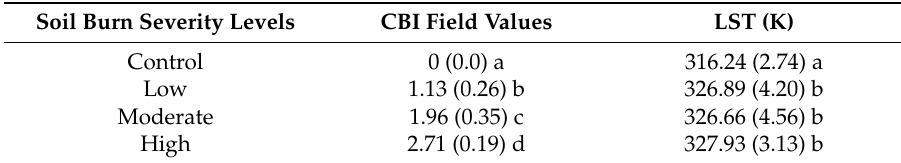
Table 5. Mean values and ( ± standard deviation) for CBI field and LST image values. The Kruskal–Wallis post hoc results are shown. Within a column means followed by the same letter are not significantly